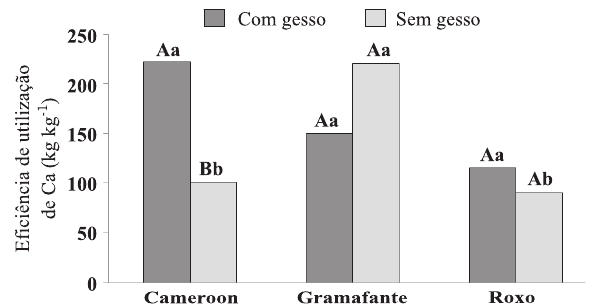
figura 4. Eficiência de utilização de cálcio por três variedades de capim-elefante, na presença e ausência de gesso. letras maiúsculas compa- cada variedade, e letras minúsculas comparam as variedades na presença e ausência de gesso. letras iguais não diferem (tukey, p ≤